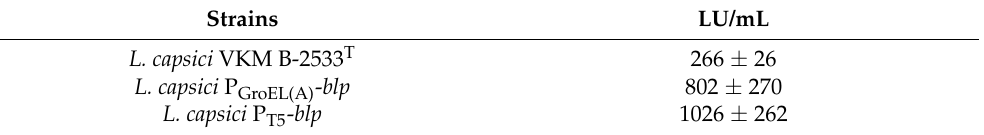
Table 1. Bacteriolytic activity of the culture liquid of L. capsici